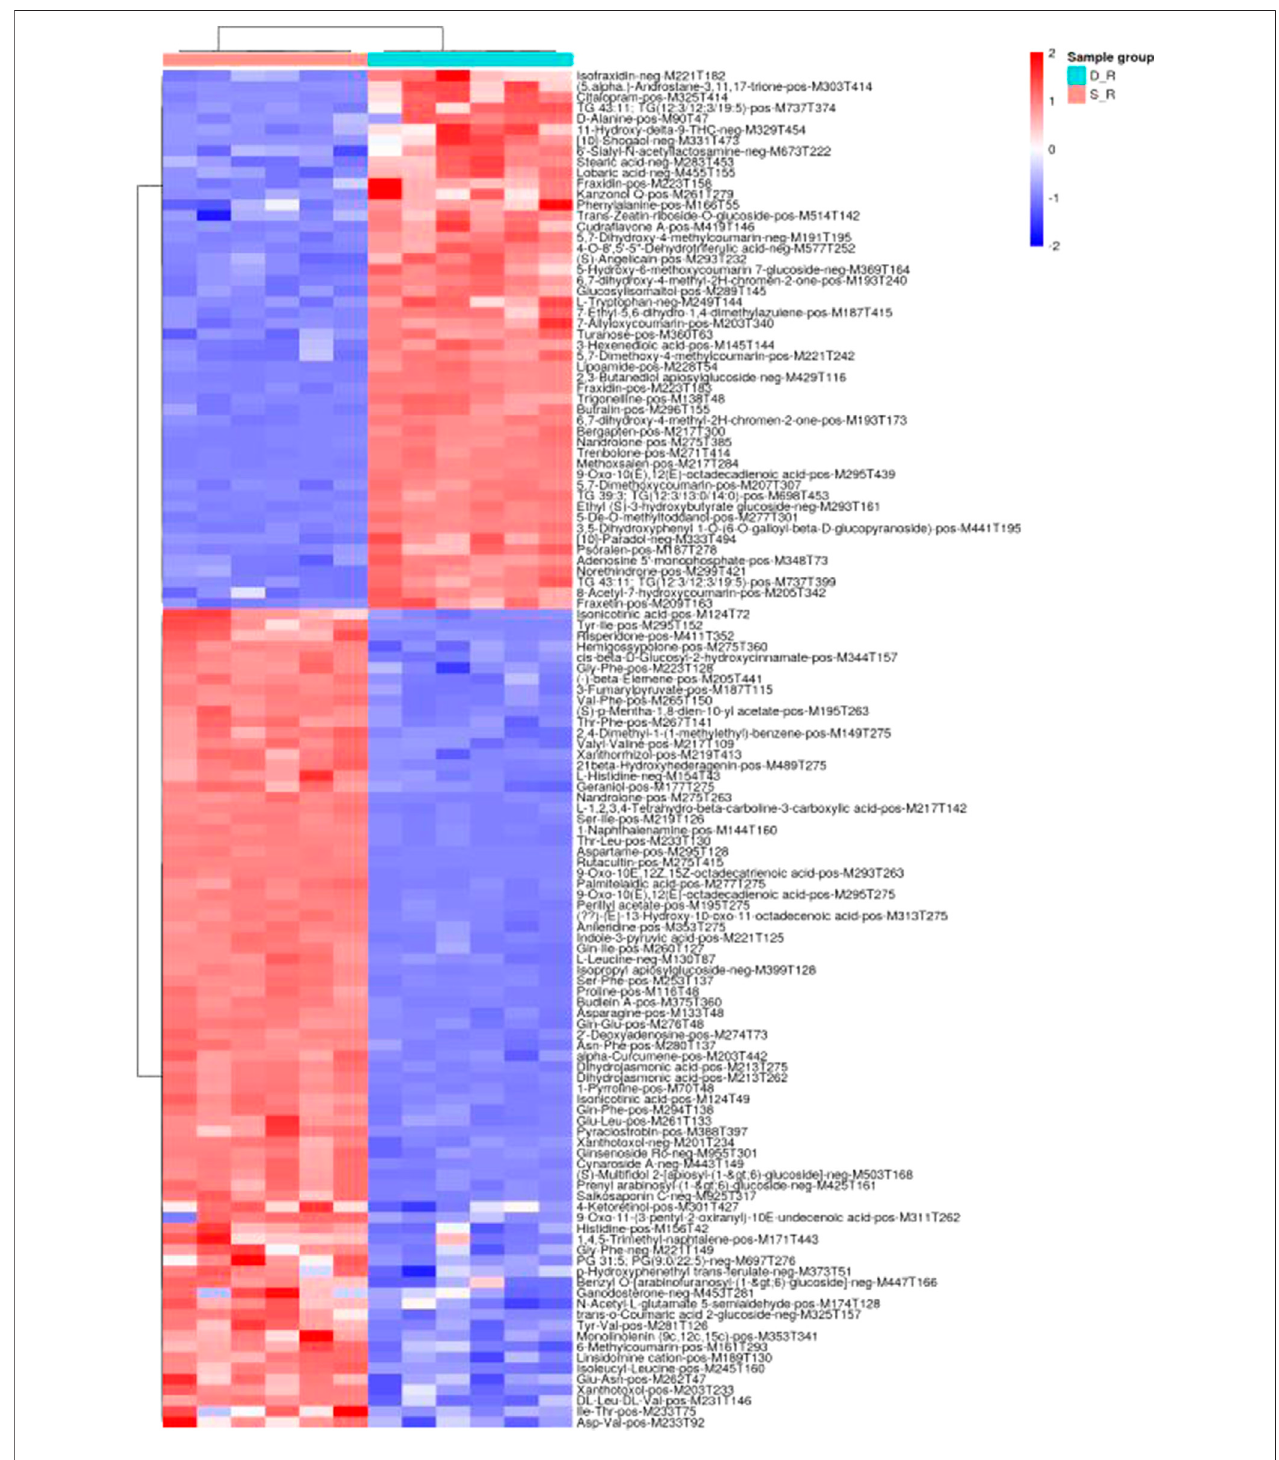
FIGURE 12 | Results of hierarchical clustering analysis of altered metabolite pools in the single-headed roots and double-headed roots ( p < 0.01). Heatmap color indicate the abundance of each metabolite in the single-headed roots and double-headed roots.